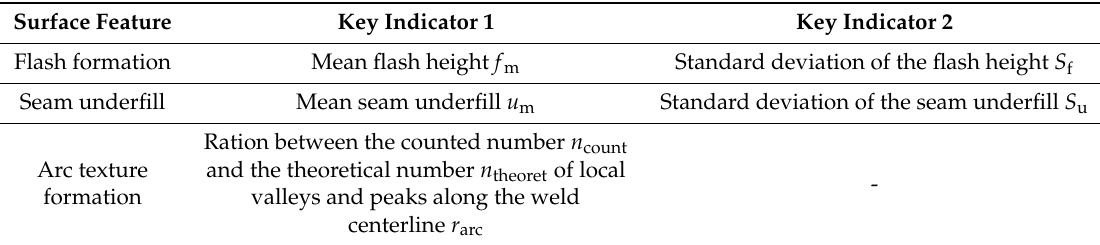
Table 1. Surface characteristics, which were correlated to the mechanical properties.